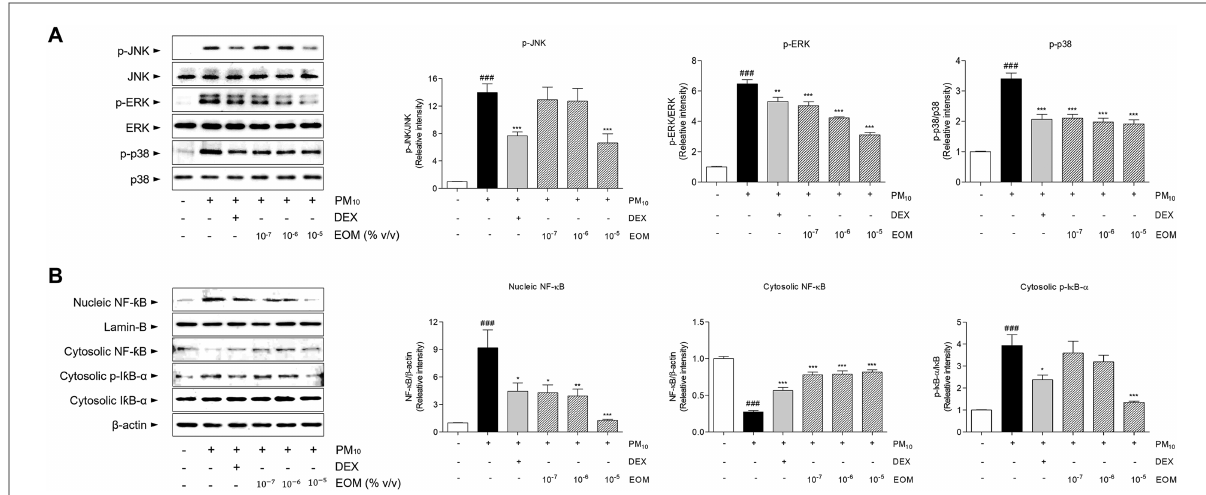
FIGURE 9 The expression of MAPK-NF- κ B signaling in PM10-treated RPMI2650 cells. The expressions of phosphorylated MAPKs including JNK, ERK and p38 were shown with the quanti fi ed values (A). The expressions of nucleic and cytosolic NF- κ B, and cytosolic I κ B- α were shown with the quanti fi ed values (A). Results are presented as mean ± standard error of the mean. ### p < 0.001 vs. CTR group * p < 0.05, ** p < 0.01 and *** p < 0.001 vs. PM10-treated group. MAPK, mitogen-activated protein kinase; NF- κ B, nuclear factor kappa-light-chain-enhancer of activated B